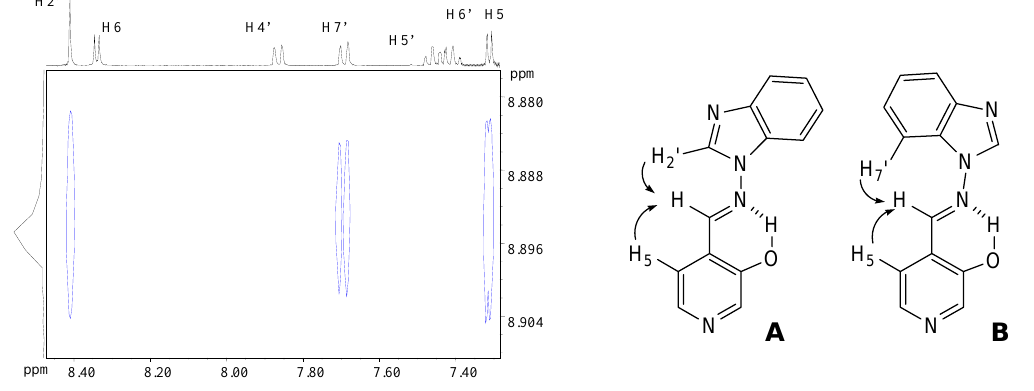
Figure 3 . NOESY spectrum of compound 7a in CDCl